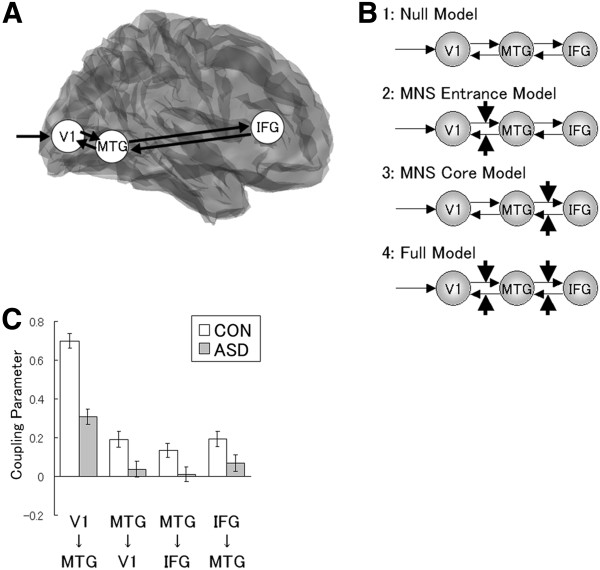
Models and results of dynamic causal modeling (DCM) regarding the mirror neuron system (MNS). A. Analyzed brain regions rendered on the spatially normalized brain. V1 = Primary visual cortex; MTG = Middle temporal gyrus; IFG = Inferior frontal gyrus. B. Analyzed models. Thin arrows indicate intrinsic connections between brain regions. Bold arrows indicate the modulatory effects of dynamic presentation. C. Mean coupling parameters (± SE) for the control (CON) and autism spectrum disorders (ASD) groups. Statistical comparisons showed that all parameters were significantly weaker in the ASD than in the control group (t-test, p < .05).